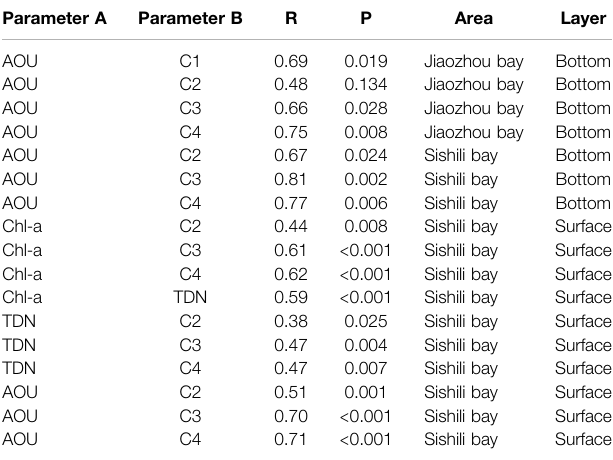
TABLE 4 | Summary of correlations between different